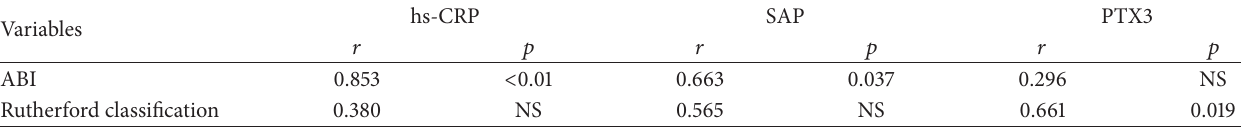
Table 3: The correlation between the severity of peripheral arterial disease and serum